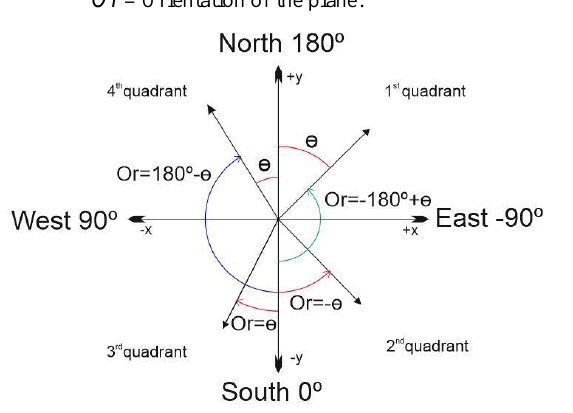
Figure 6: Result of the extraction of each roof using the Euclidean cluster extraction algorithm.